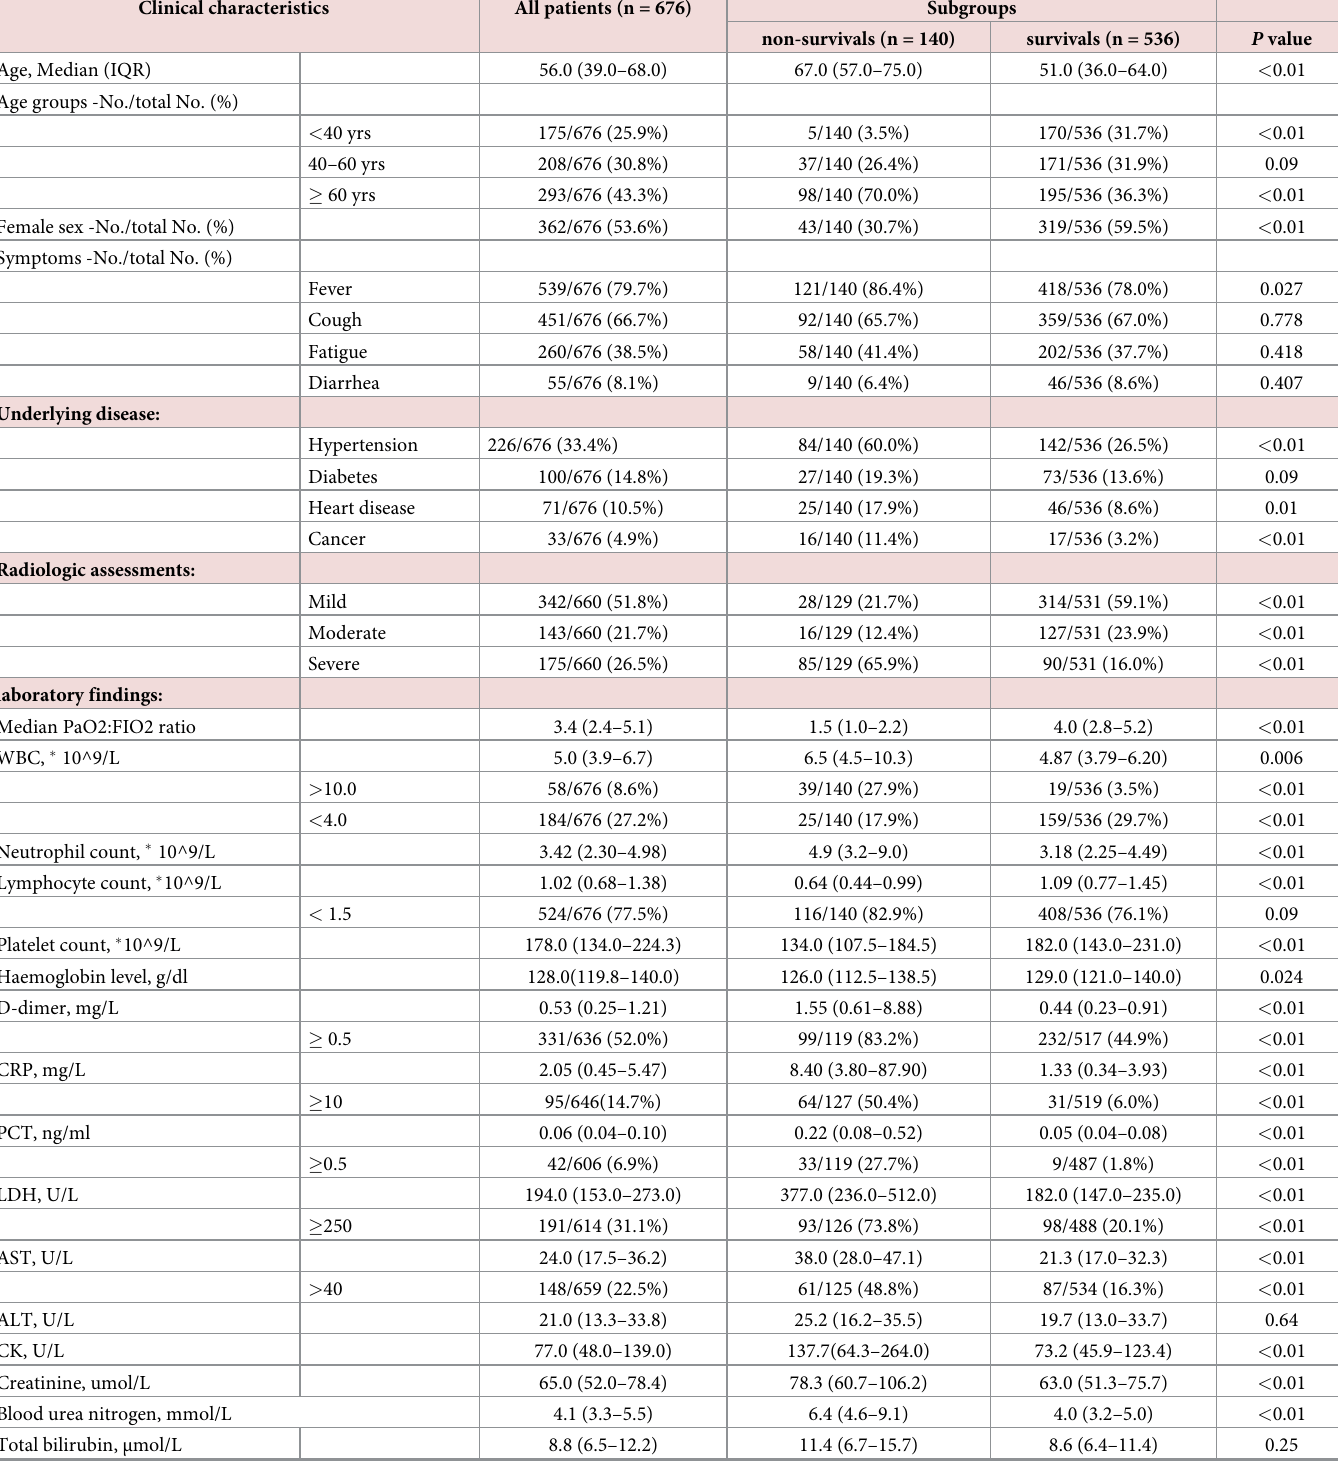
Table 1. Clinical characteristics of the patients with COVID-19 on the initial